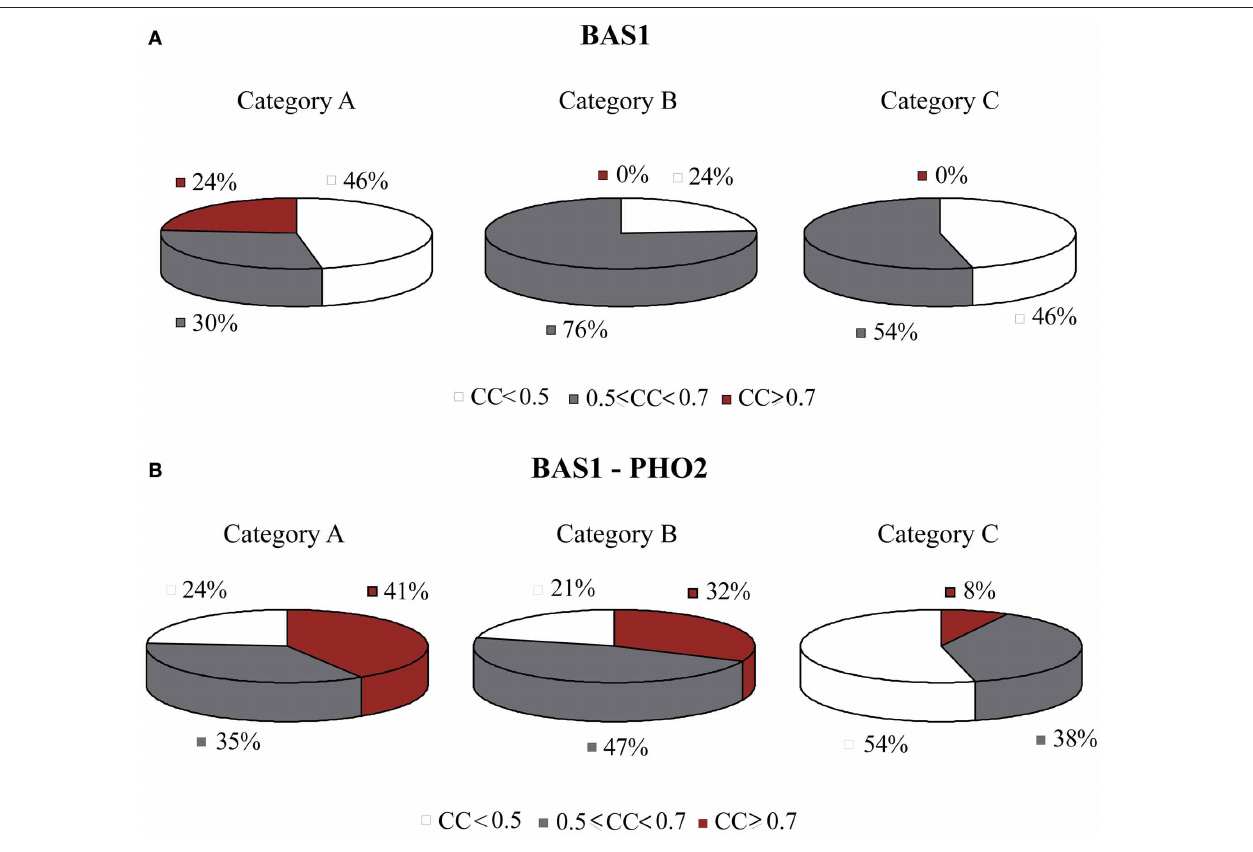
FIGURE 6 | Pie charts showing the grouped correlation coefficients (CC) of the ANN models in the three stress categories. (A) Results correspond to genes in modules regulated by BAS1 alone. Successful ANNs (CC > 0.7) are found only for stress conditions in